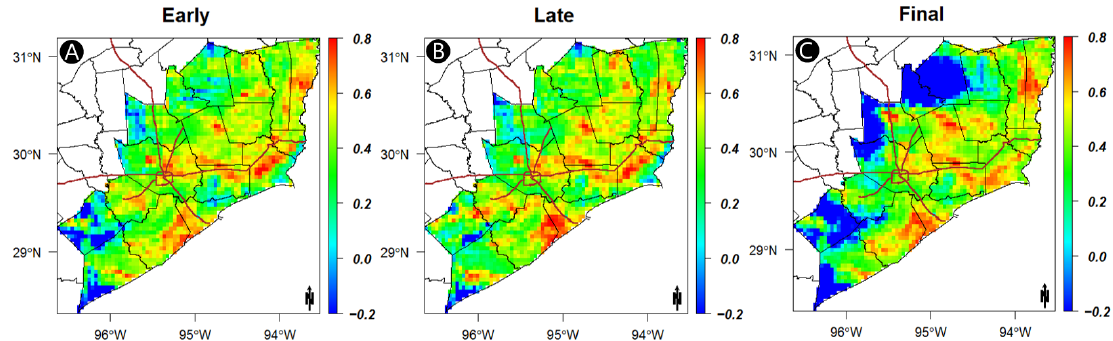
Figure 9. Spatial distribution of KGE for the IMERG ( A ) Early-, ( B ) Late-, and ( C ) Final-run products during Tropical Storm Imelda. Table 2. The areal average of the basic statistical indices of the satellite products.